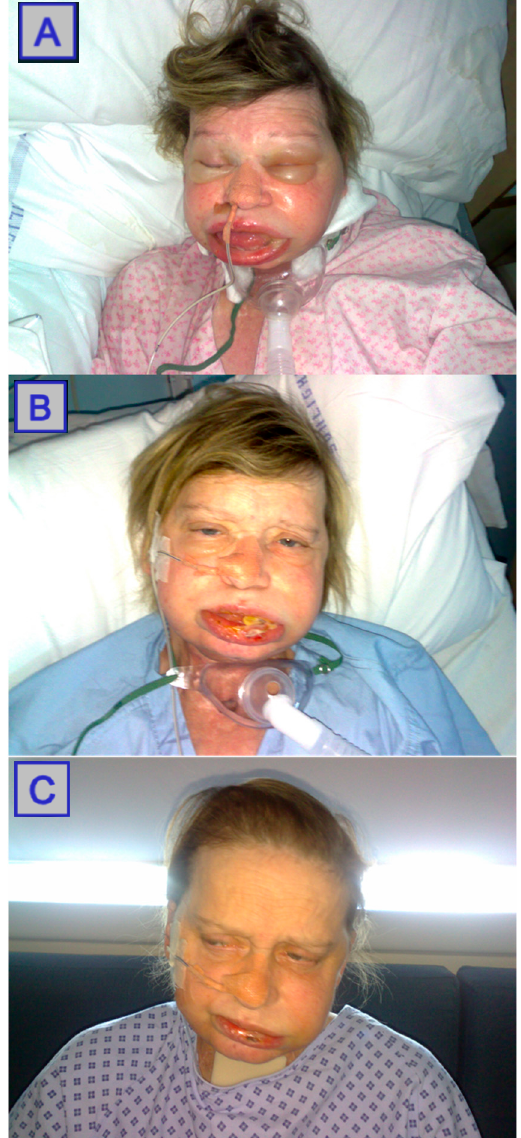
Figure 4. Images displaying post-PDT swelling. Day 2 post-PDT ( A ). Day 4 post-PDT ( B ). Day six post-PDT ( C ). Reprinted with permission from ref. [38]. Copyright 2008 Oncol.